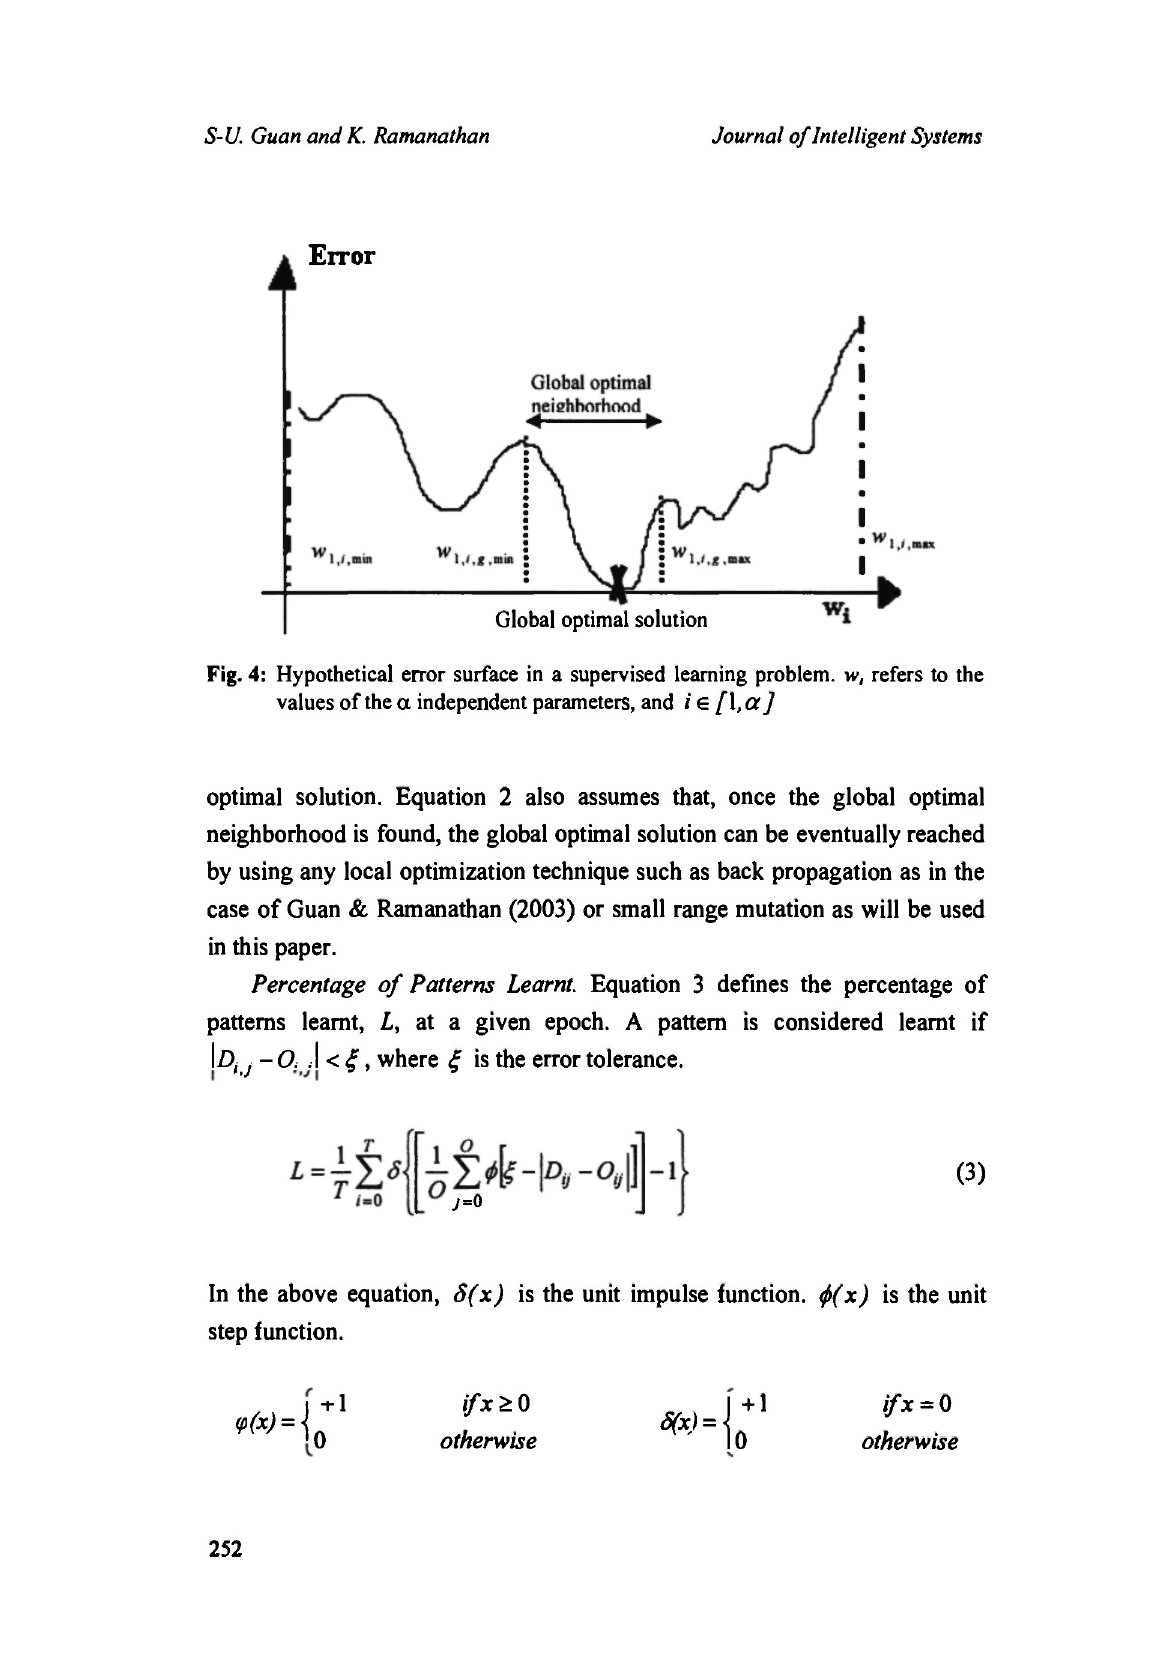
Fig. 4: Hypothetical error surface in a supervised learning problem. u>, refers to the values of the α independent parameters, and i e [I, a]